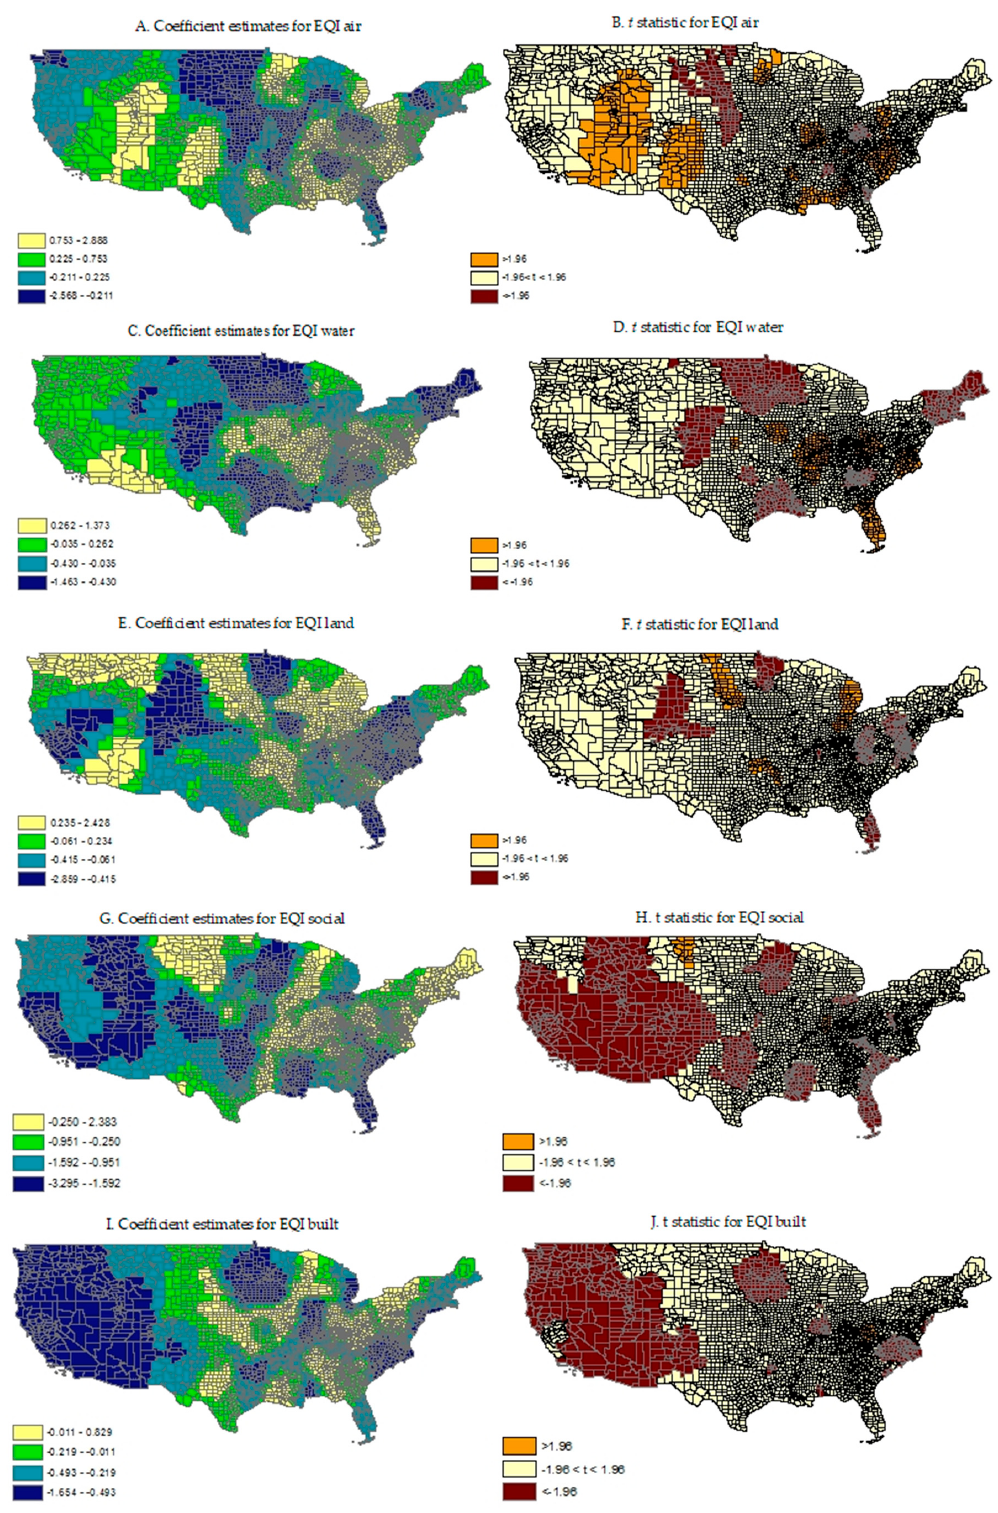
Figure 2 Estimated county ‐ specific impacts of standardized EQI subdomains on physical inactivity Figure 2. Estimated county-specific impacts of standardized EQI subdomains on physical inactivity prevalence using GWR. prevalence using